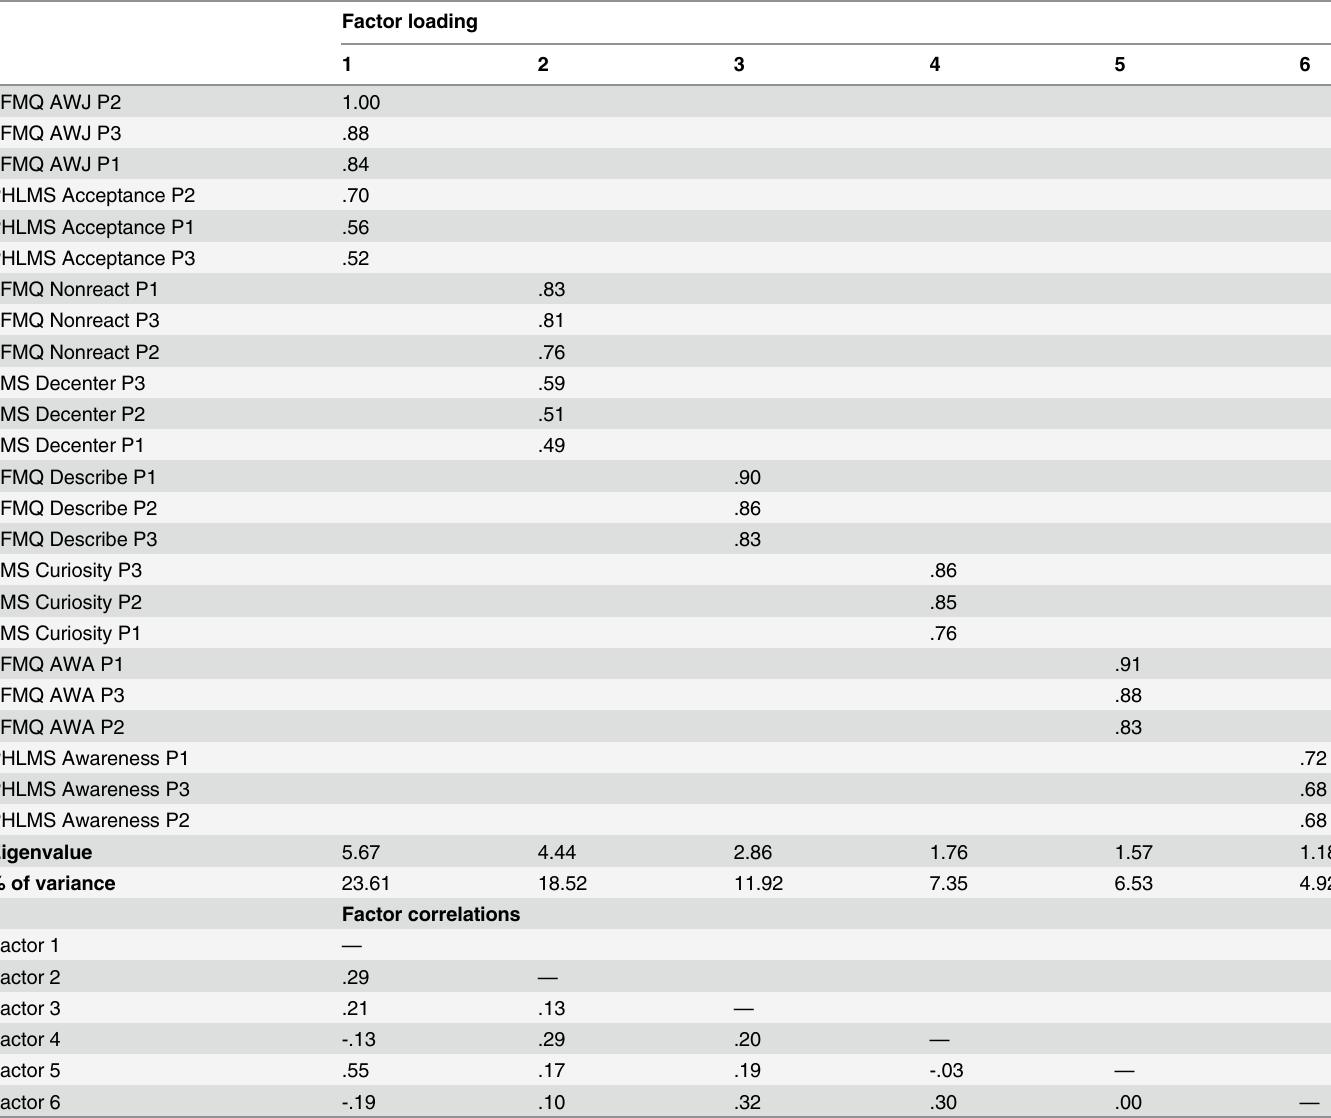
Table 5. Pattern Matrix for Promax Six-Factor Solution Extracted from FFMQ, TMS, and PHLMS Item Parcels Corresponding to Each Facet or Sub- scale and Factor Correlation Matrix in Sample 2.Parcel. Factor